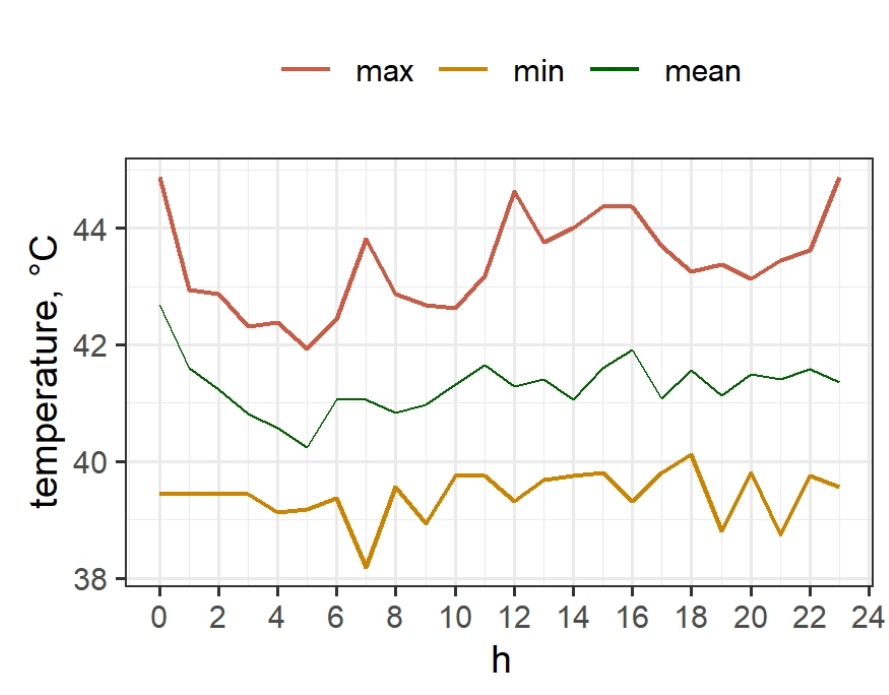
Figure 8. Minimum and maximum temperatures of circulating water on week days (DR), and average temperatures of circulating water on weekends (DW) on the furthest riser